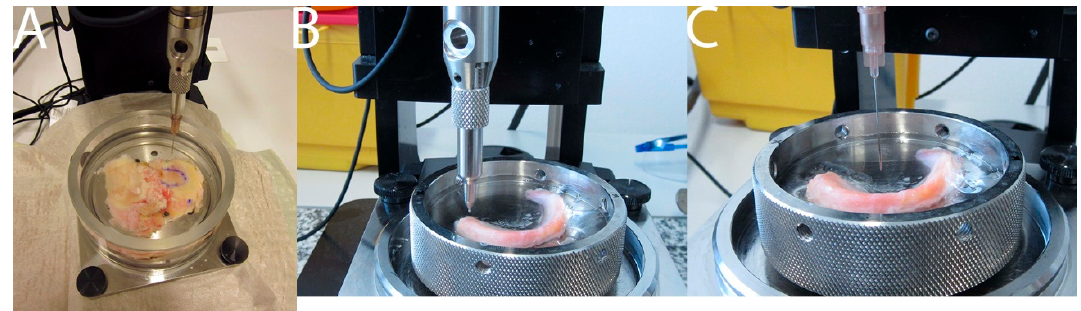
Figure 1. ( A ) Mach-1 thickness measurement by needle method (joint cartilage); ( B ) Mach-1 Indentation (meniscus); ( C ) Mach-1 thickness measurement by needle method (meniscus).